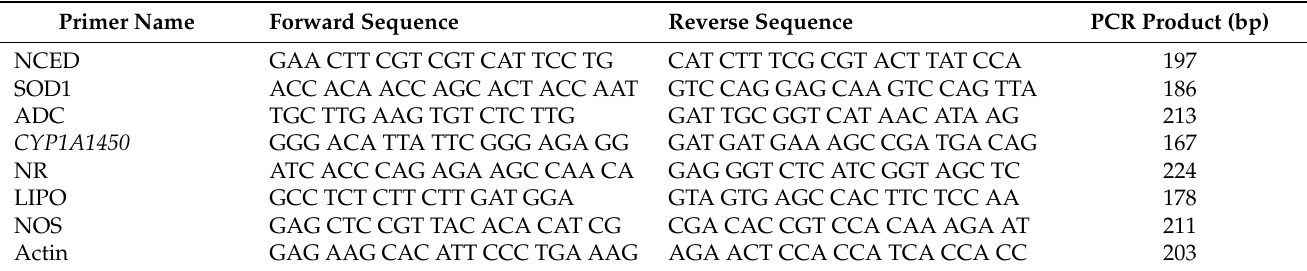
Table 1. Names and sequences of primers used in RT-PCR and PCR product length in base pairs